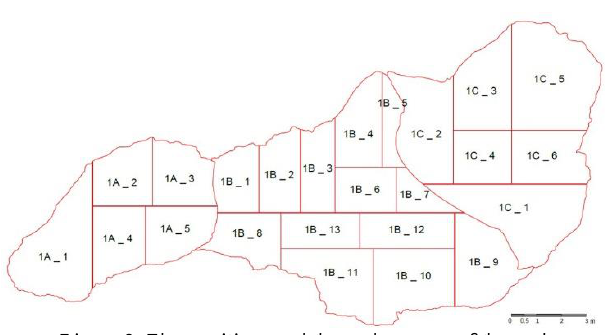
Figure 8: The positions and the code names of the rock segments. Elevation facing SW.